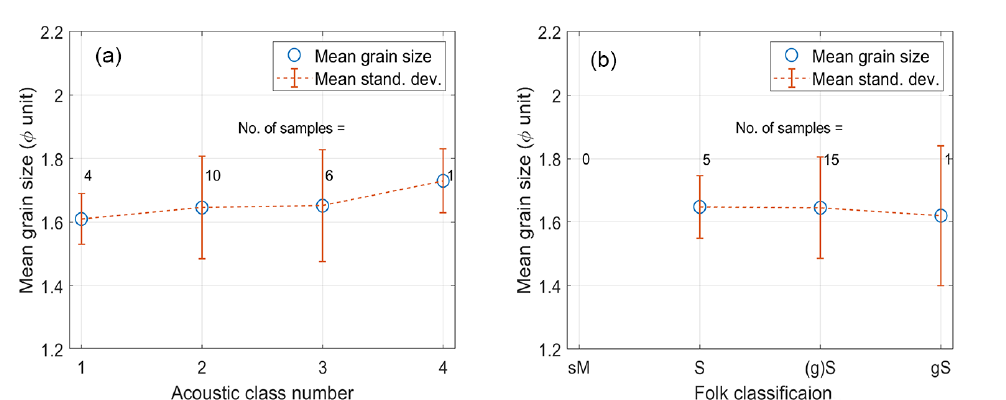
Figure 11. Averaged mean grain sizes and standard deviations versus acoustic class numbers ( a ) and Folk classification ( b ) for 21 of the grab samples with M z from 1.50 to 1.74 φ .